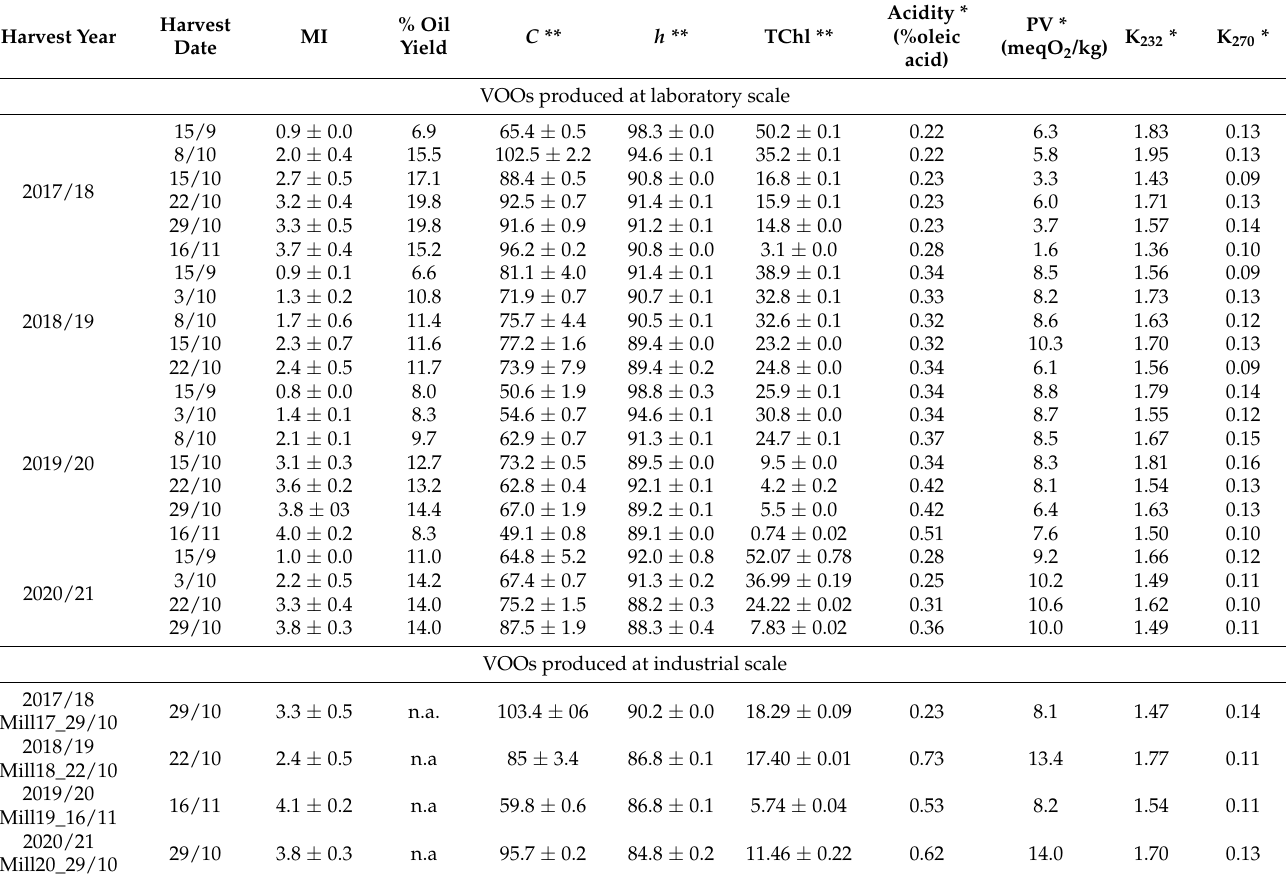
Table 4. Effect of the harvest date on the maturity index (MI) of olives cv. ‘Chondrolia Chalkidikis’ and ‘Chalkidiki’, on the extracted oil yield and quality indices of the VOOs extracted from olives cv. Chondrolia Chalkidikis and Chalkidiki